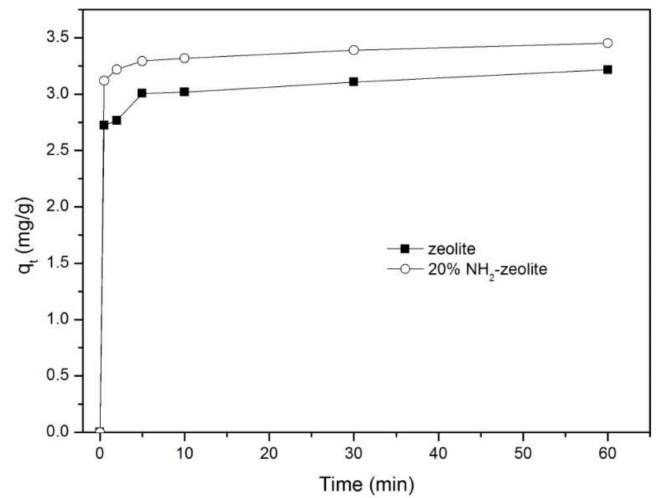
Figure 12. Adsorption properties of zeolite and 20% amino functionalized zeolite sample towards naphthalene at different adsorption times.